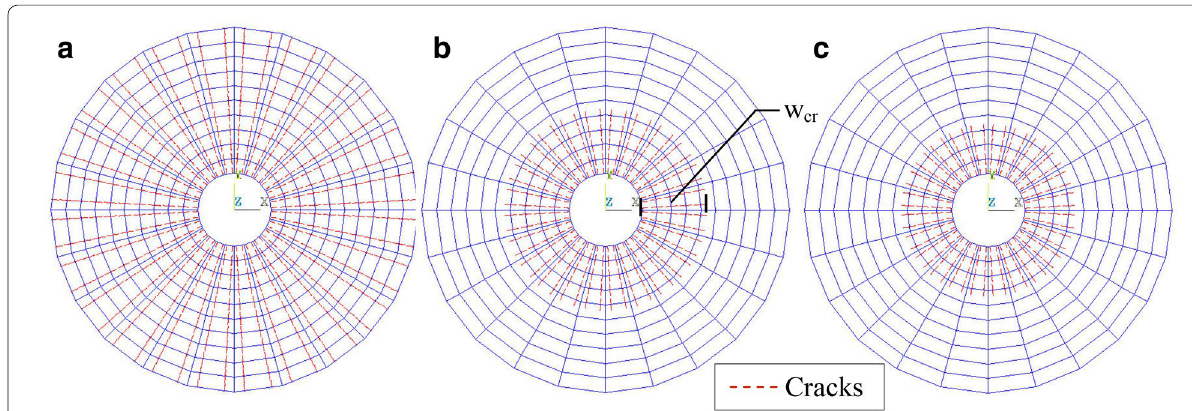
Fig. 14 Crack pattern obtained from nonlinear analyses: a ρ h,min